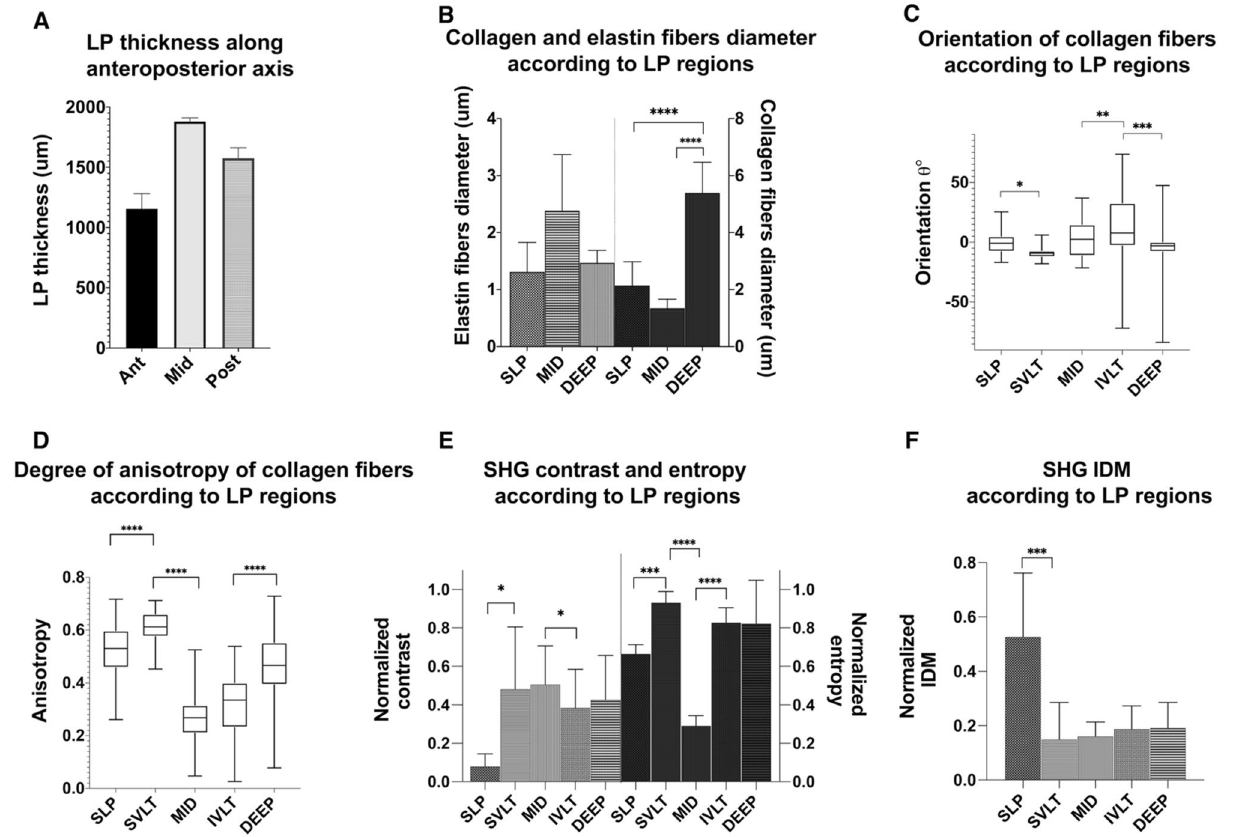
Figure 7. Quantitative analysis of SHG vocal fold features. The thickest section of the vocal fold (VF) along the anteroposterior axis (A) is in the mid-membranous region with 1.88 mm (± 0.02 mm). Collagen fibers are thicker than elastin fibers regardless of the lamina propria (LP) depth (B) . They are predominately aligned with the VF edge in the SLP and deep, as shown by the orientation (C) and degree of anisotropy (D) box plot. The second-degree statistics analysis shows that contrast and entropy (E) along with the inverse difference moment are useful features to distinguish the SLP from the superficial vocal ligament transition (SVLT).